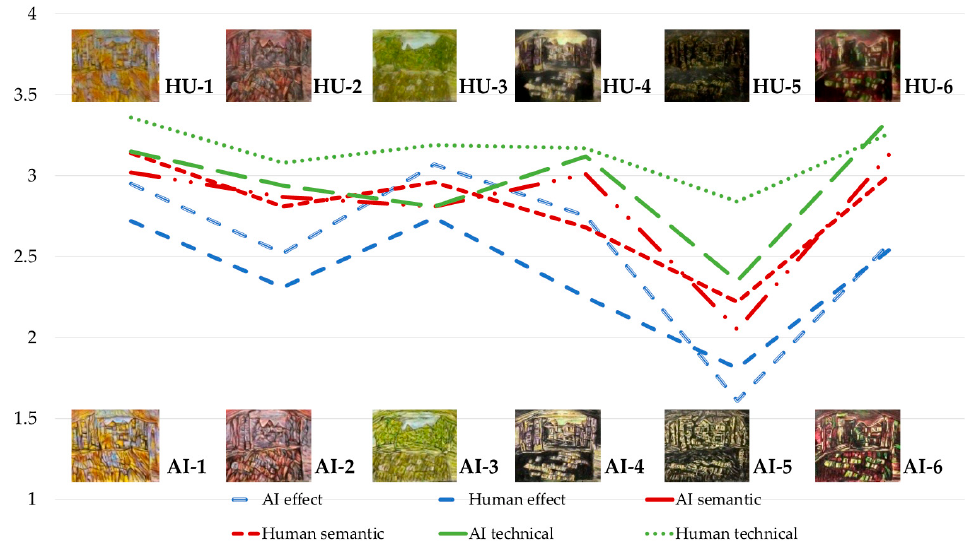
Figure 6. Average scores for affect relating to Home Sweet Home.